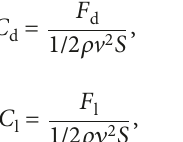
Figure 7: Aerodynamic noise computation domain of high-speed trains.